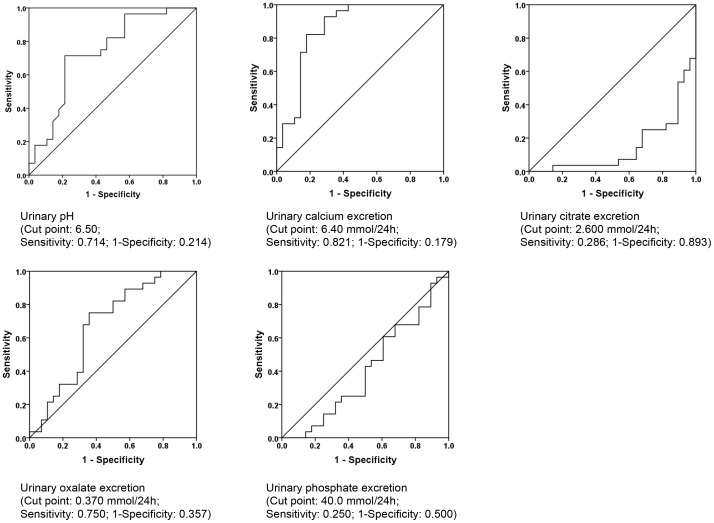
Receiver operating characteristic analyses.